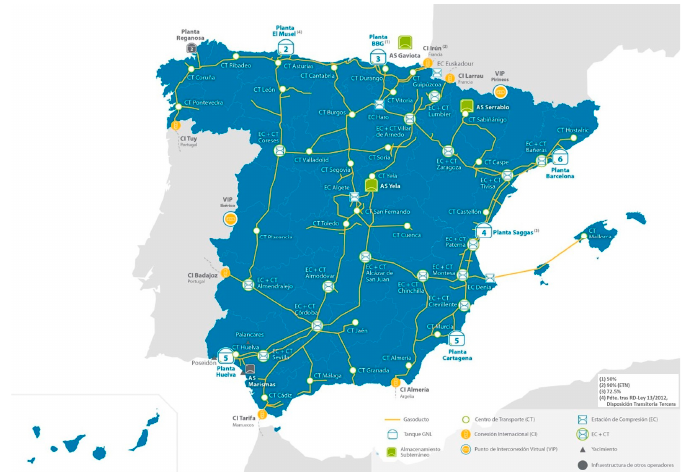
Figure 9. Map of Enagás infrastructures in Spain [29].